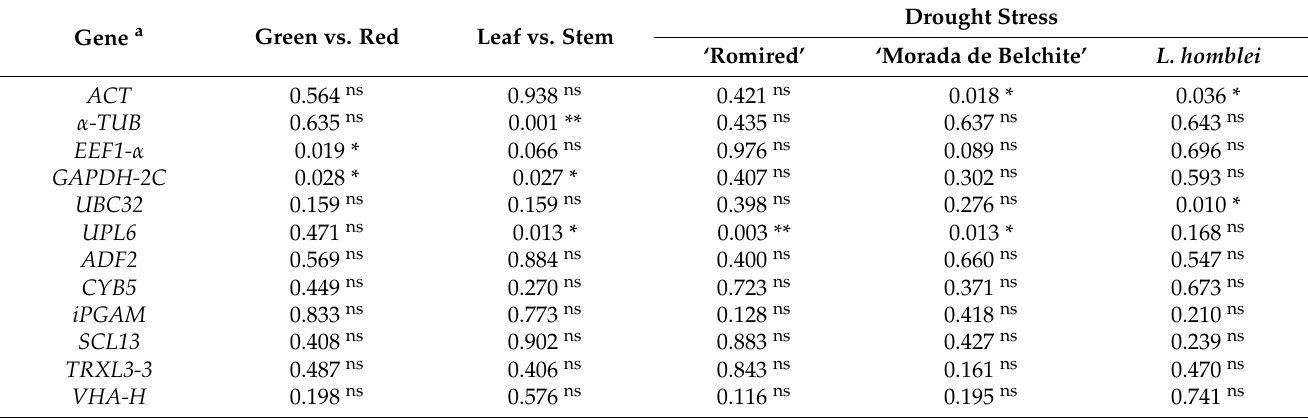
Table 2. F-values resulting from ANOVA of gene counts for traditional housekeeping genes and new candidate reference genes (RGs) among groups of each experiment: green vs. red, leaf vs. stem, and drought